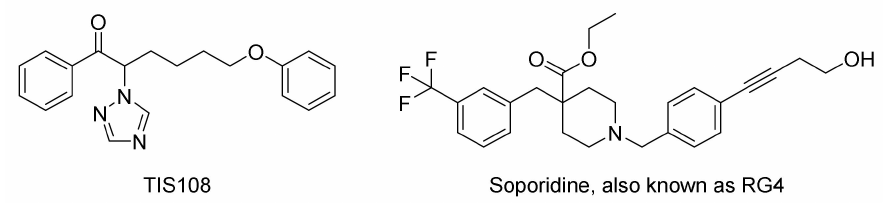
Figure 8. Examples of strigolactone